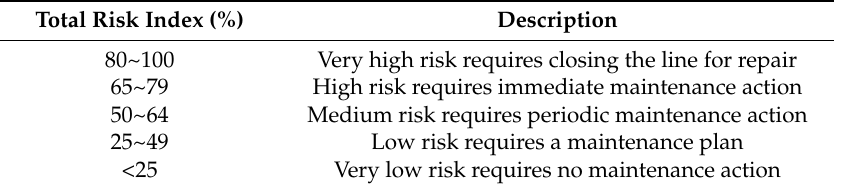
Table 6. Description of risk index in the hazard map system.